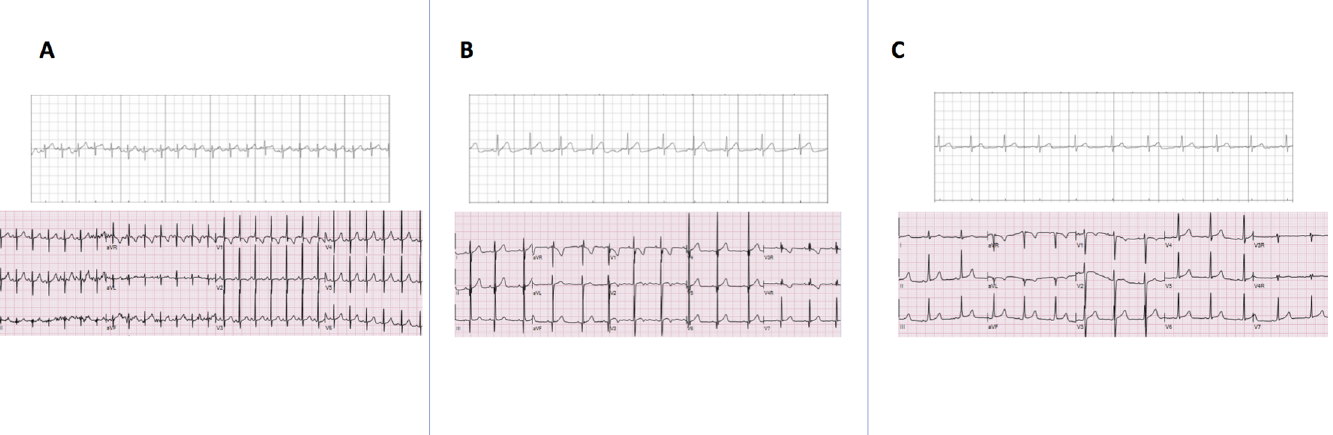
Fig 1. Side-by-side examples of serially acquired KM tracings and 12-lead ECGs exemplifying diagnostic quality of the KM for a patient in group A (panel A), group B (panel B), and group C (panel C).